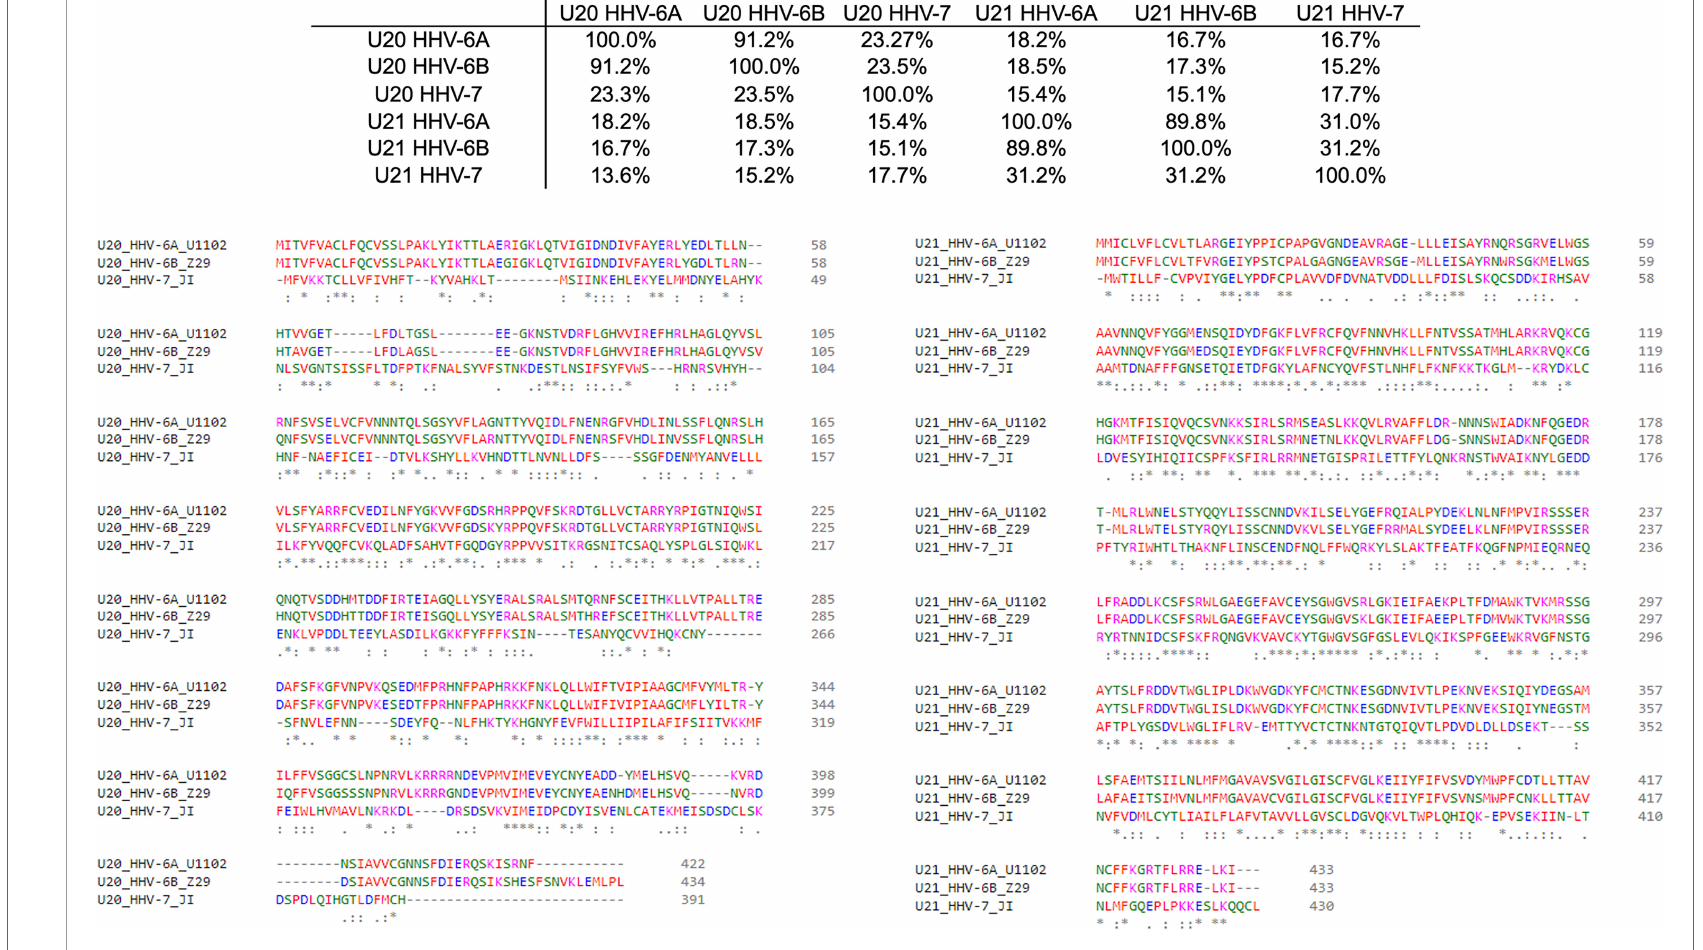
FIGURE 4 | Sequence homology of U20 and U22 from HHV-6A, HHV-6B, HHV-7. The amino acid sequences for U20 and U21 from HHV-6A, -6B, and -7 were retrieved from the Uniprot database ( Table 3 ). They were then aligned using Clustal Omega (49). Top: Sequence identity matrix for U20 and U21 from HHV-6A, HHV-6B, and HHV-6. Bottom Left: Alignment of U20 sequences from HHV-6A (strain U1102), HHV-6B (Z29) and HHV-7 (JI). Amino acids are colored by type. Identities are indicated by an asterisk and similarities are indicated with a colon. Bottom Right: Alignment of U21 sequences from these same strains, colored and annotated as in